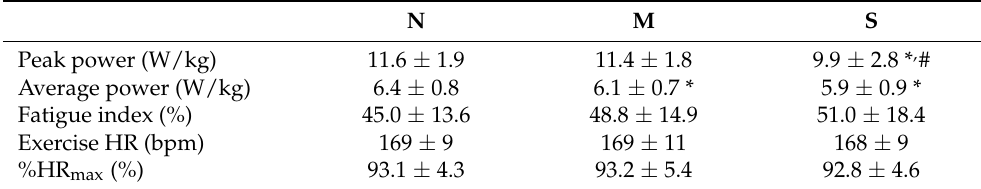
Table 2. Variables of SIE in normoxia, moderate hypoxia, and severe hypoxia.